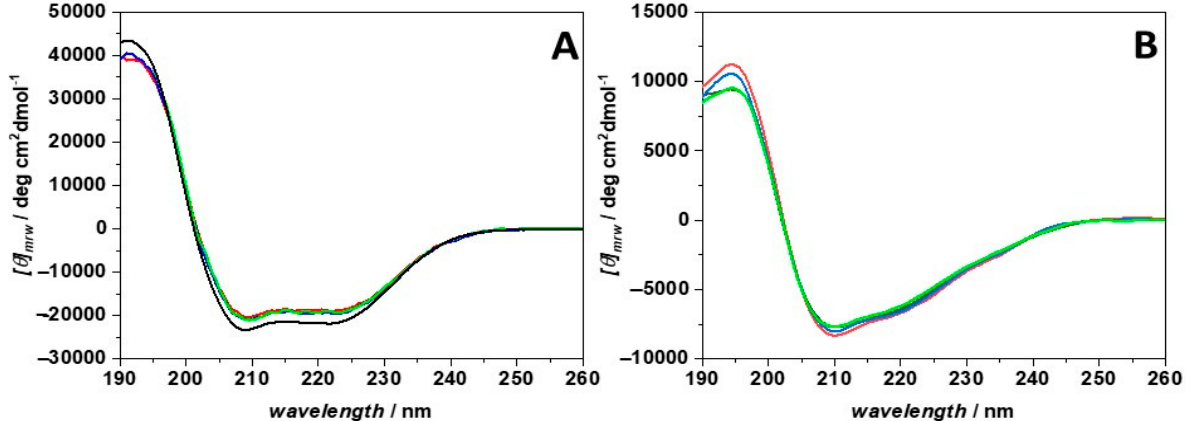
Figure 4. Far UV-CD spectra of ( A ) HSA and ( B ) hTf recorded in the absence (black spectra) and in the presence of increasing concentrations of AziRu. The concentrations of both proteins were 1.5 μ M. The AziRu concentrations were: 1.5 μ M (red spectra), 7.5 μ M (blue spectra) and 75 μ M (green spectra). The spectra were recorded at 20 °C by using a 0.1 cm path length quartz cuvette.